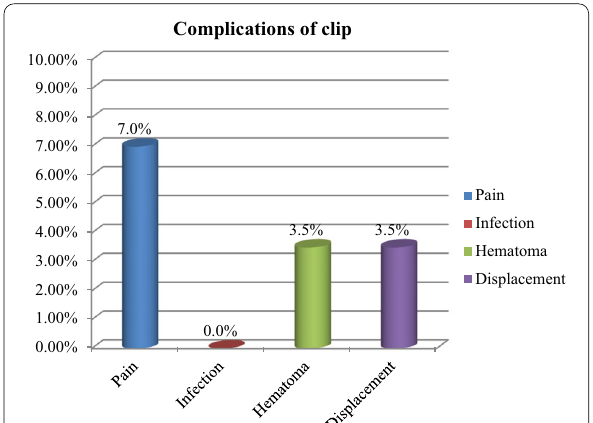
Fig. 4 Complications of clips insertion distribution among study group